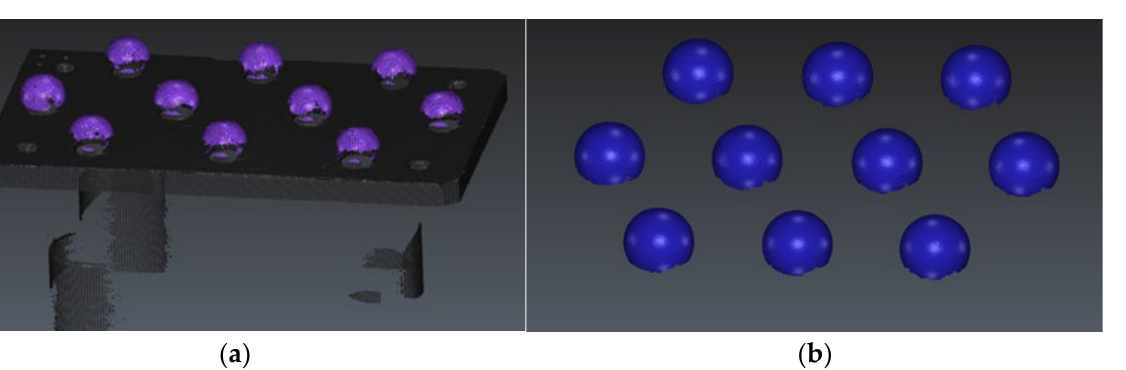
Figure 8. Noncontact measurements of sets of spheres after each treatment. ( a ) After sandblasting ( b ) After chemical etching.